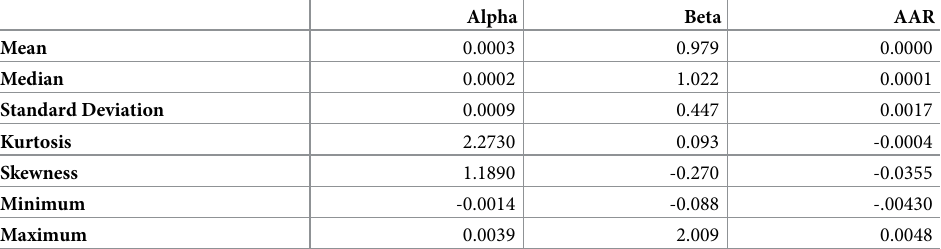
Minimum -.00430 Maximum 0.0039 2.009 0.0048 Beta shows the relationship between market and stock returns. Alpha shows the risk involved with the stock. The AAR over the estimation window is shown in the last